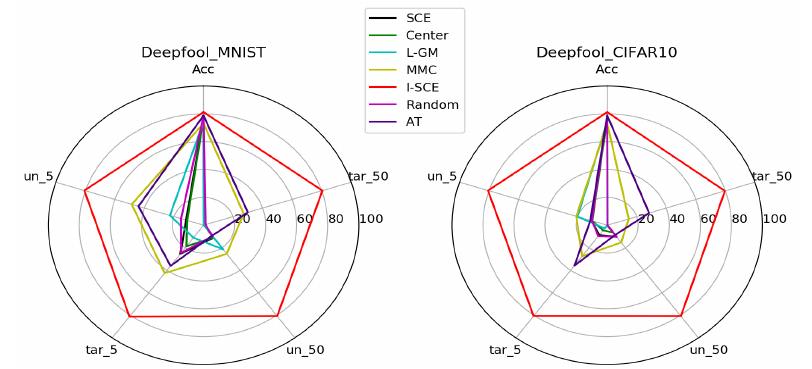
Figure 11. Performance (%) of shallow neural networks under PGD attack on CIFAR10.